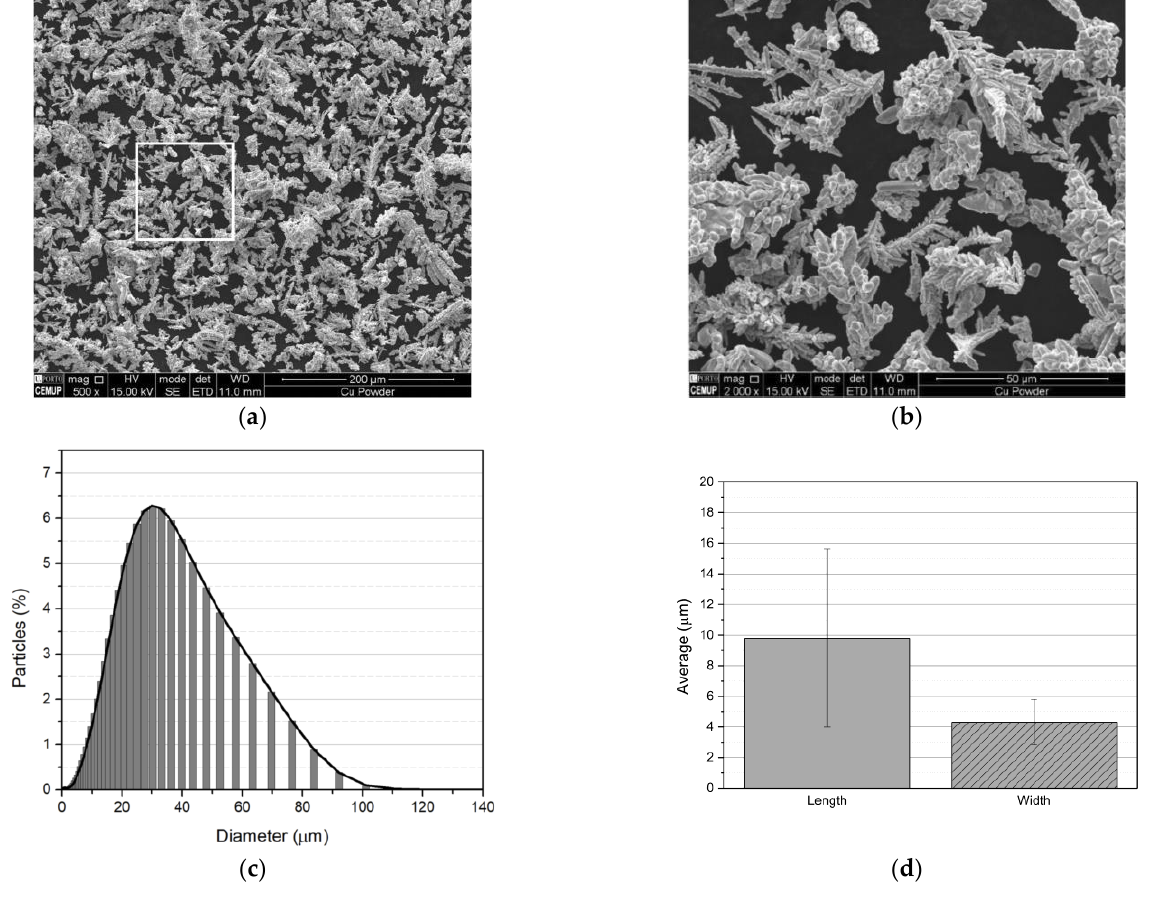
Figure 1. ( a ) SEM images of the as-received Cu powders, ( b ) higher magnification of the region marked in (a), ( c ) particle size distribution, and ( d ) average length and width of the particles.